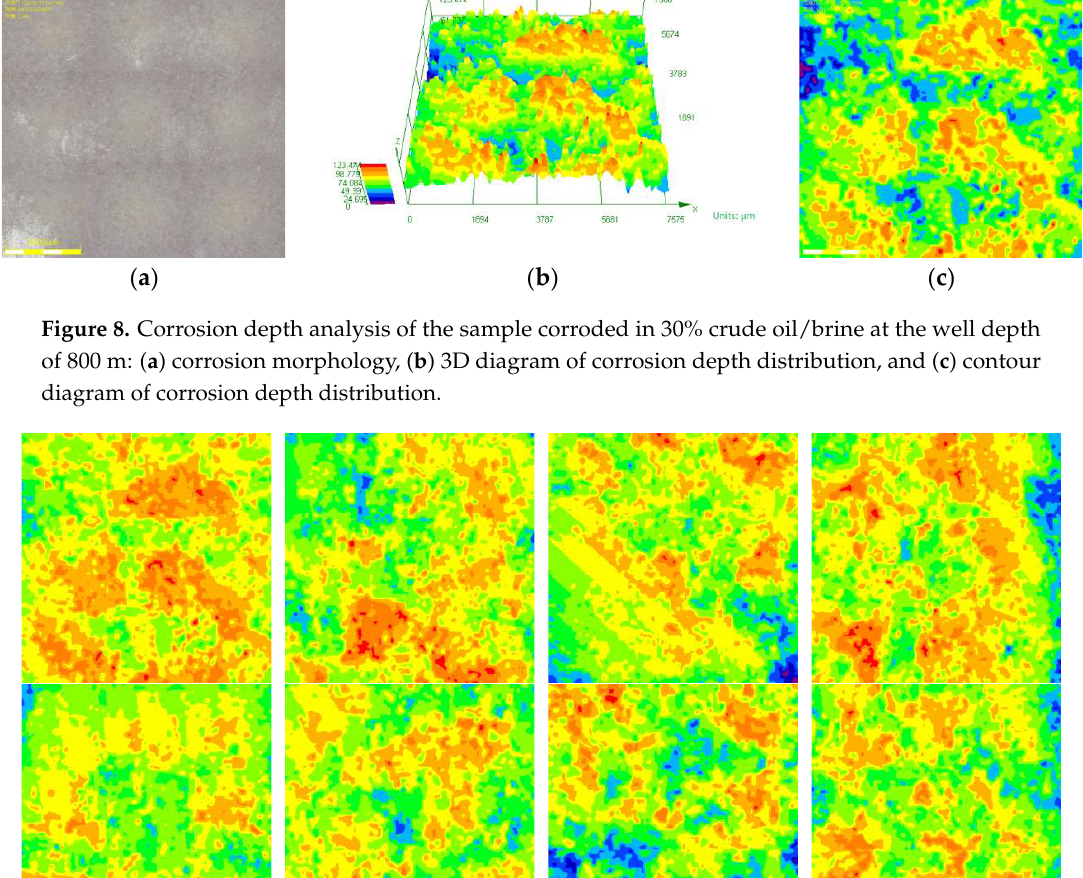
Figure 8b. The size of one contour diagram of corrosion depth distribution was 7612 µ m × 7612 µ m,